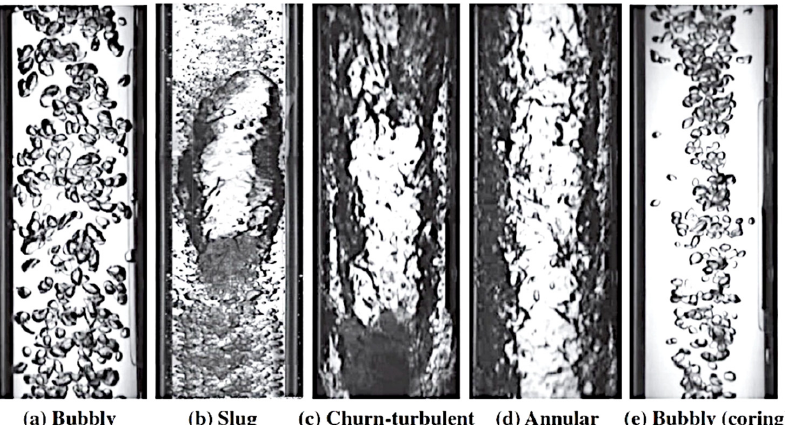
Figure 1. The visualized two-phase flow regime map, reprinted with permission from [14] 2017, Elsevier.